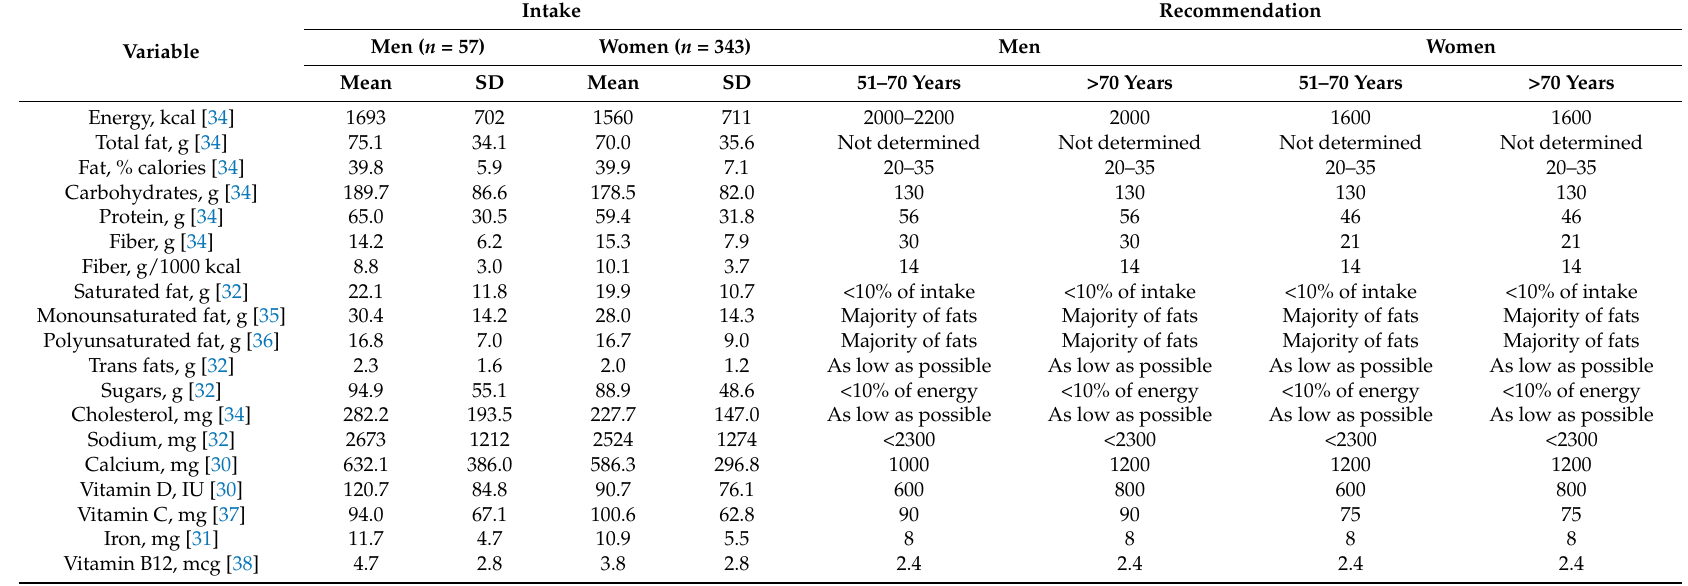
Table 2. Habitual nutrient intake of urban overweight and obese primarily African American older adults with osteoarthritis ( n = 400).